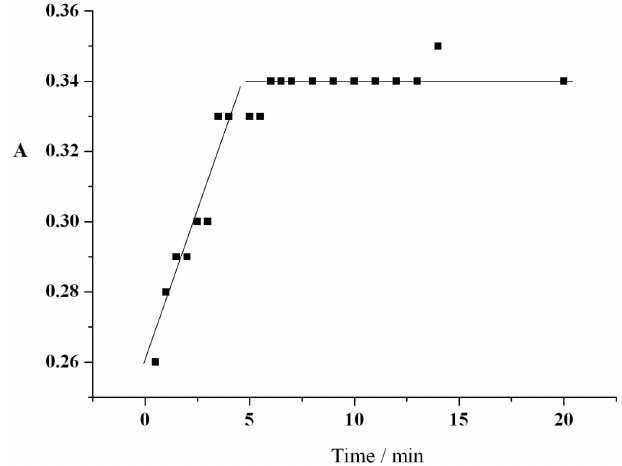
FIGURE 4 - Influence of time on absorbance of complex ions measured at 715 nm. Indigo carmine solution = 1x10 -4 mol L -1 and 1x10 -4 mol L -1 Cu(II) solution in 0.1 mol L -1 carbonate buffer solution at pH